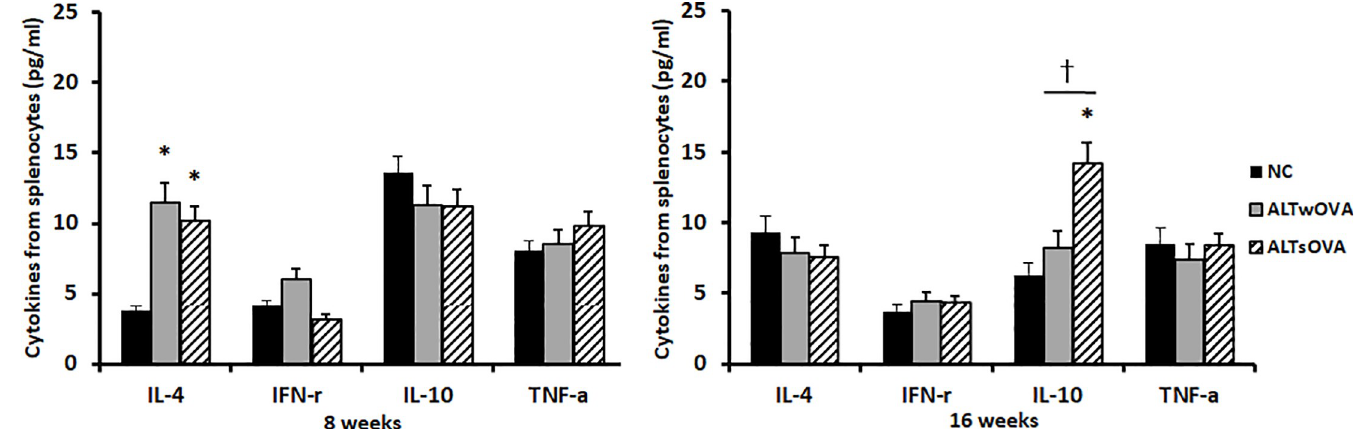
Fig 4. Chemical mediator production from splenocyte after stimulated with 100 ug/mL of Alteranria for 72 hours. IL-4 production was significantly increased in allergic and non-allergic mica at 8 weeks and IL-10 production was significantly increased in non-allergic mice (n = 7 mice per group). NC: negative control, ALTwOVA: Alternaria instillation with ovalbumin (OVA) presensitization, ALTsOVA; Alternaria instillation without ovalbumin (OVA) presensitization. � p < 0.05 vs NC group, †p < 0.05 vs with or without OVA group.